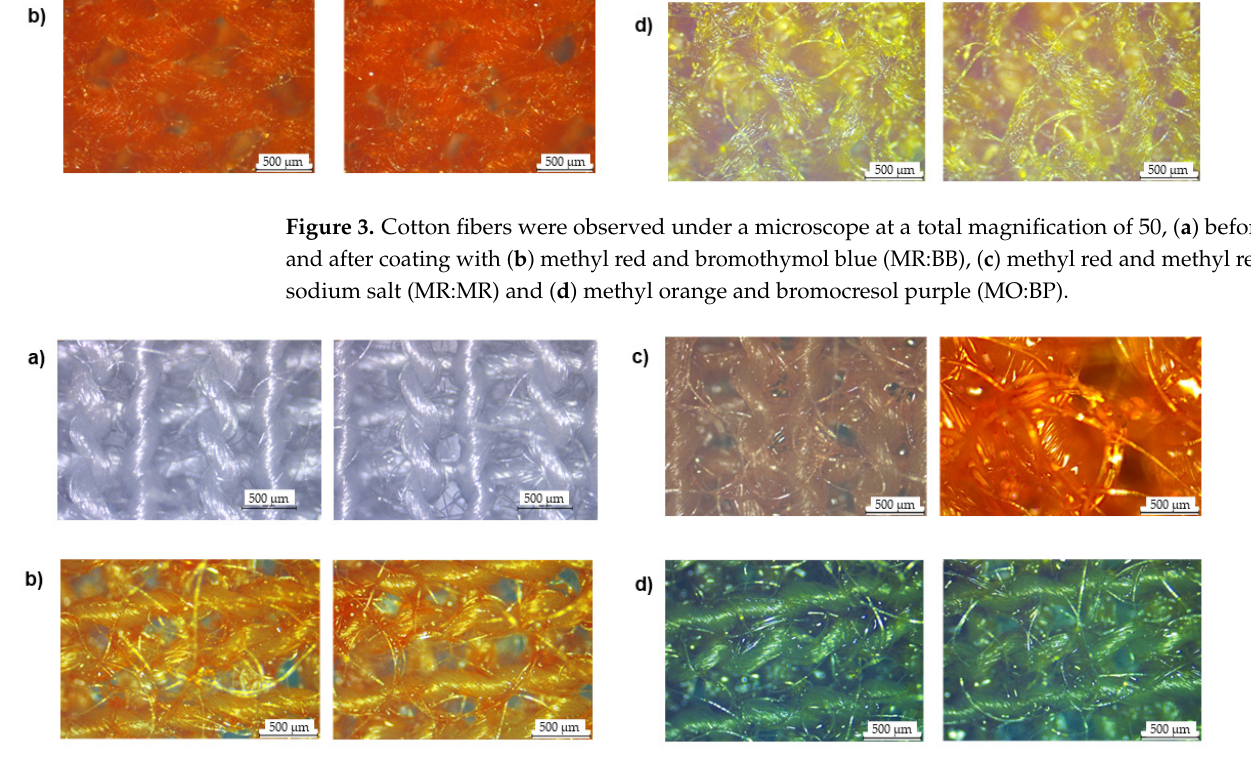
Figure 4. Polyester fibers were observed under a microscope at a total magnification of 50, ( a ) after coating with ( b ) methyl red and bromothymol blue (MR:BB), ( c ) methyl red and methyl red sodium salt (MR:MR) and ( d ) methyl orange and bromocresol purple